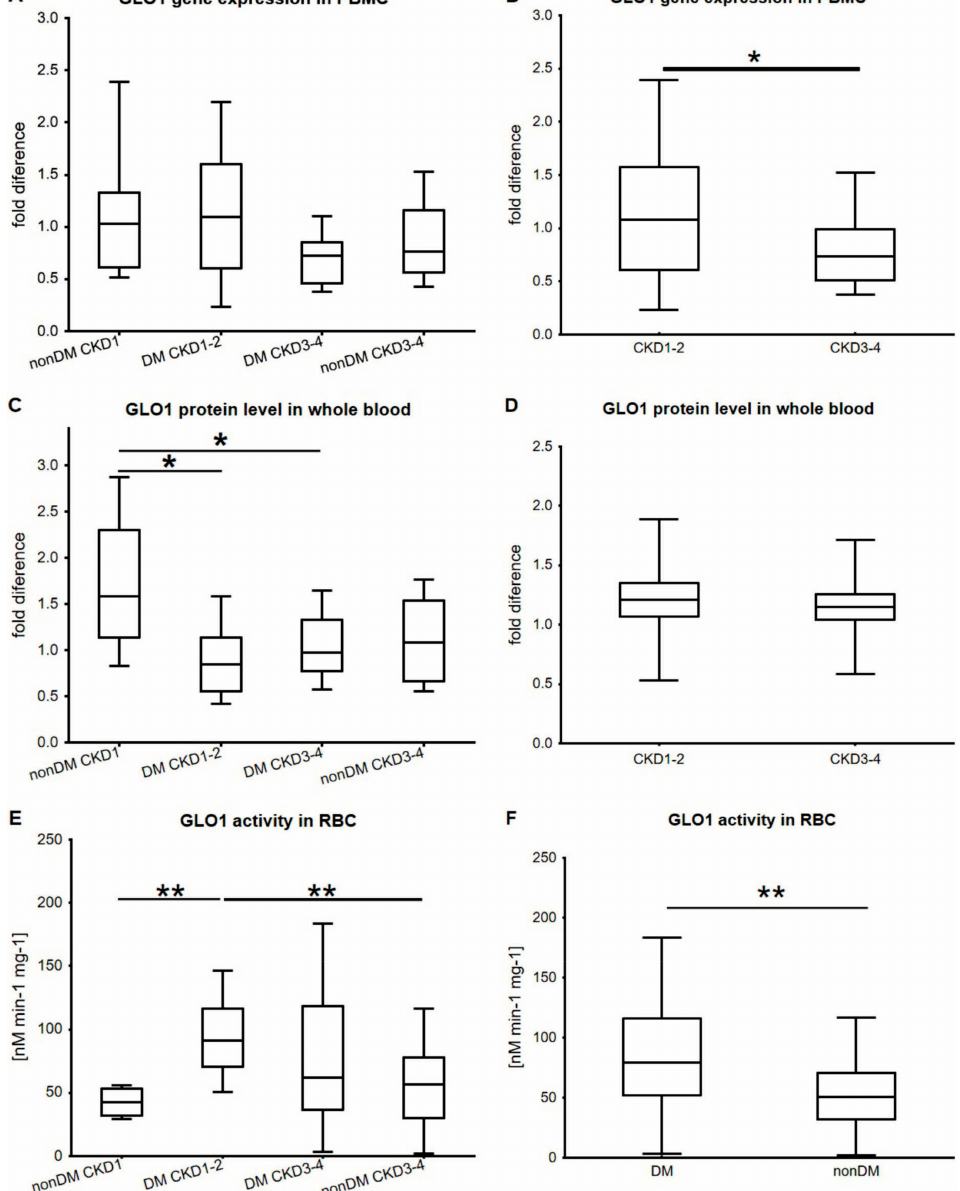
Figure 1. Fold differences in GLO1 gene expression ( A ), protein level ( C ) and activity ( E ) between four groups of patients. Comparison of GLO1 gene expression ( B ), protein level ( D ) and activity ( F ) between groups pooled based on renal status ( B , D ) and between subjects with and without diabetes ( F ). Box and Whisker plots were constructed as medians, minimum, and maximum values and interquartile ranges. Symbols * over the bar refer to significant differences between the experimental conditions (* p < 0.05, ** p < 0.01, Mann-Whitney test). DM—diabetes mellitus; CKD—chronic kidney